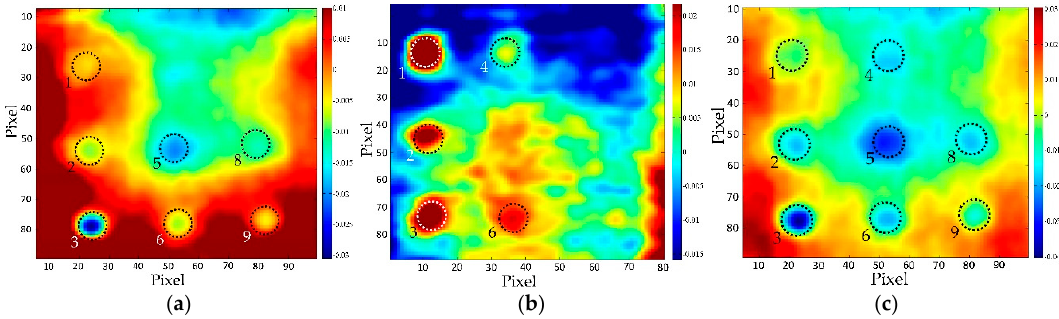
Figure 12. PCT, BM 2-2 distance 2m, top side: ( a ) heating & cooling sequence, (EOF 2 ); ( b ) heating sequence (EOF 3 ); ( c ) cooling sequence, (EOF 2 ). Table 7. SNR values obtained from images presented in Figure 12.